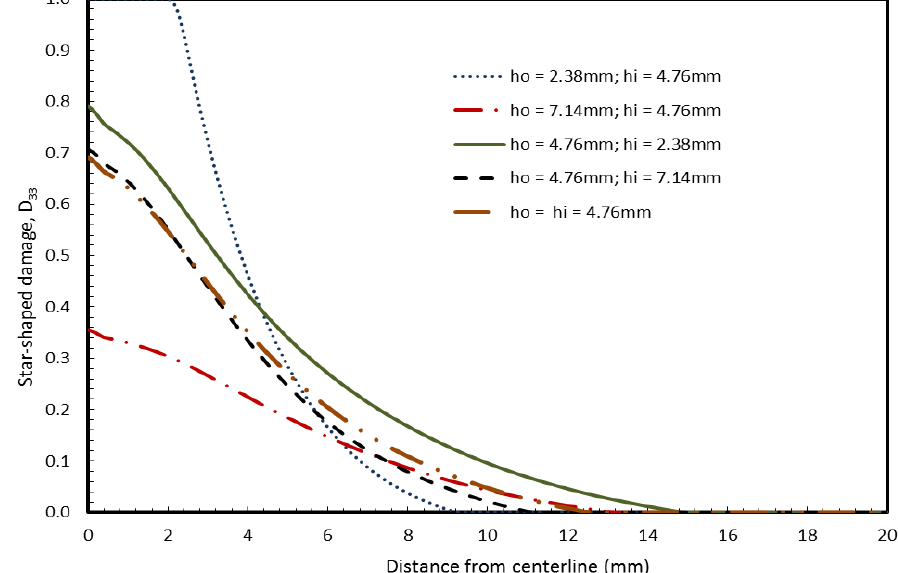
Figure 11. Effect of inner and outer plies thickness on Damage variable D at surface S2 for small missile